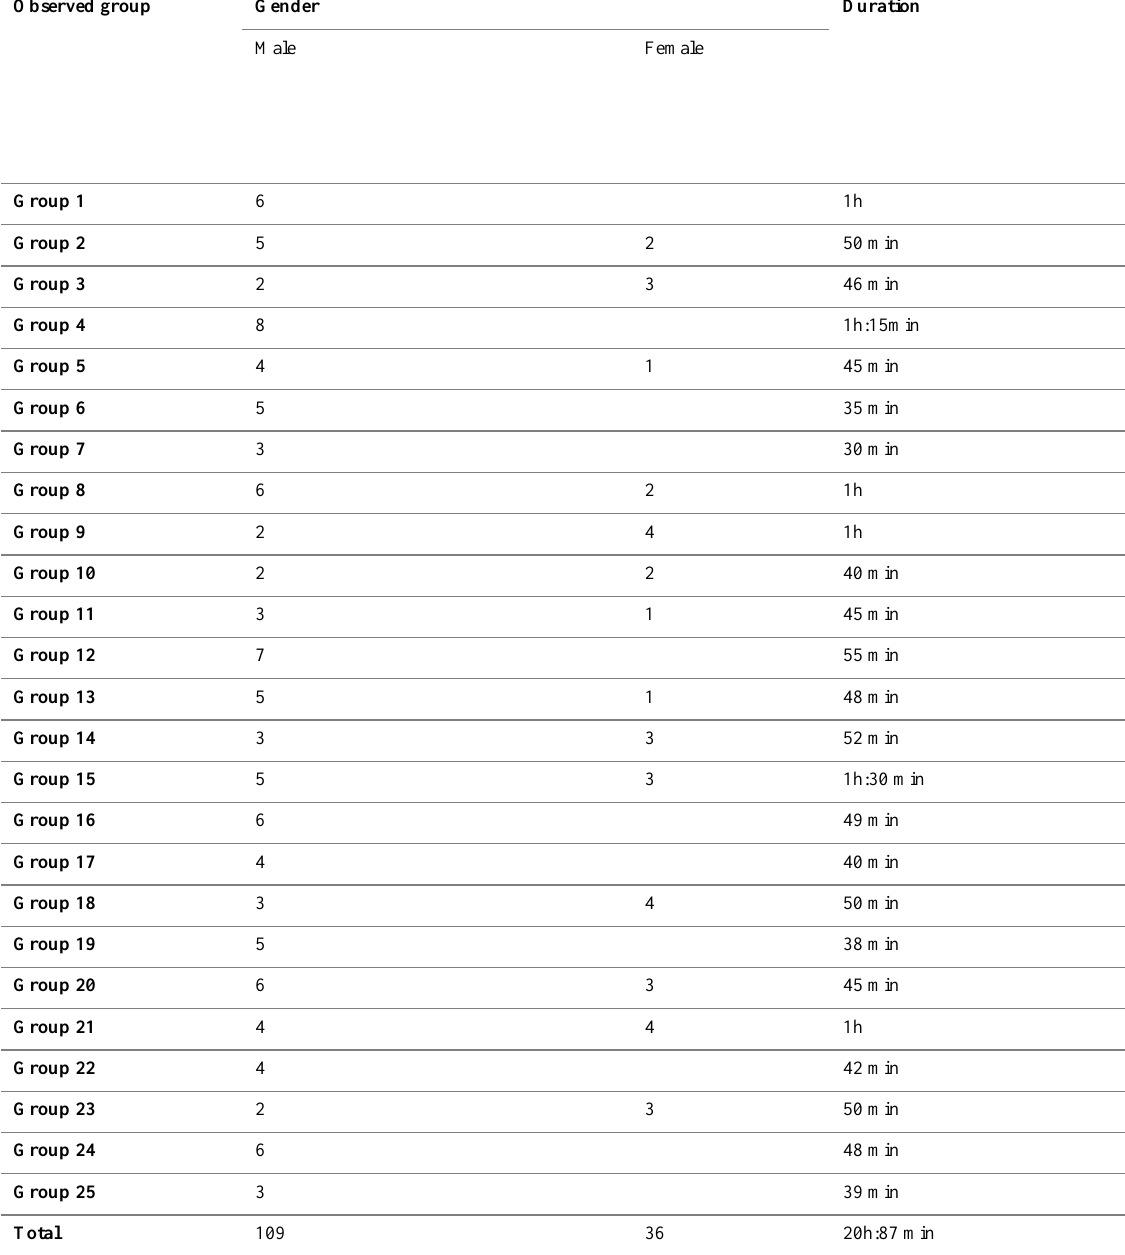
Table 1: Observation Group Demography